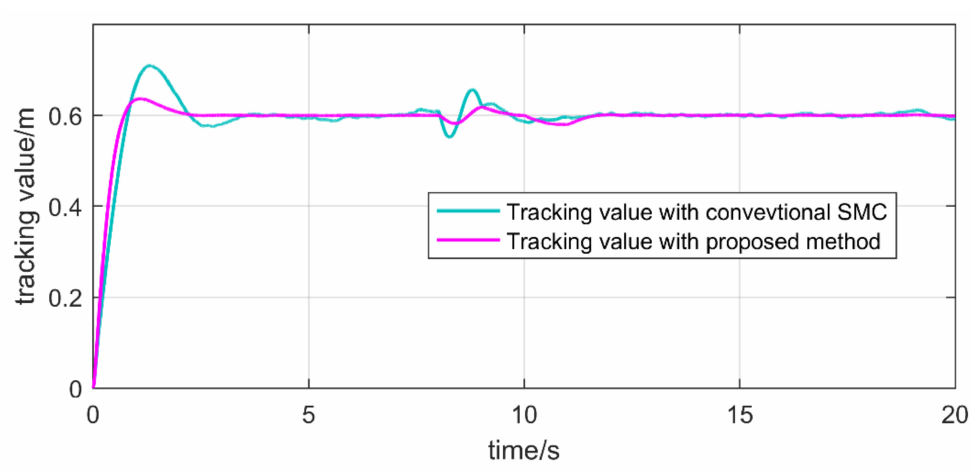
Figure 7. The tracking value of pitch.